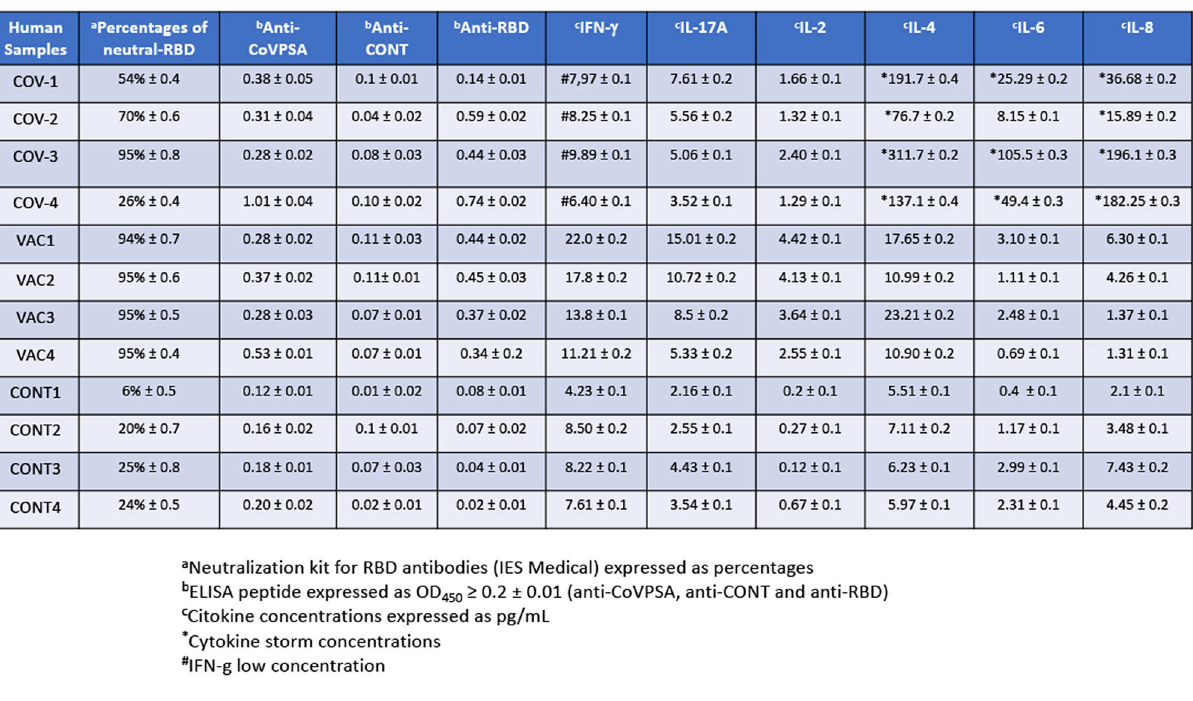
Figure 4. Correlation between neutralization IgG antibodies, anti-CoVPSA antibodies, and Th1-Th17 cytokines in COVID-19-vaccinated volunteers. The sera of 12 volunteers (four asymptomatic non-active COVID-19 patients: COV-1, COV-2, COV-3, and COV-4; four vaccinated volunteers who tested negative for SARS-CoV-2: VAC-1, VAC-2, and VAC-3 who received the Pfizer vaccine, and VAC-4 who received the Moderna vaccine; four control donors who were unvaccinated and tested negative for SARS-CoV-2: CONT1, CONT2, CONT3, and CONT4) were tested for IgG neutralization antibodies (IES Medical kit, first column), IgG anti-CoVPSA antibodies (second column), and IgG anti-RBD antibodies (third column). Reactions were developed with goat anti-human IgG and the absorbances (OD) were analyzed at 450 nm. Results are expressed as percentages of neutralization ± SD ( a column), or as the mean ± SD of triplicate